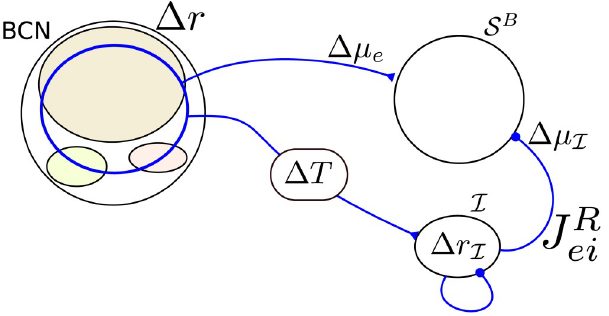
Fig 4. Tuning of the differentiator readout network to implement the operation of the differentiator readout scheme. A perturbation in the firing rate of the BCN ( Δ r ) causes a perturbation in the mean input to the RS readout neurons, Δ μ e , and a perturbation in the firing rate of the inhibitory readout population I . This change in firing rate causes a shift in the input from I to S B ( D m ). The strength of the connection from I to S B ( J R I D m þ D m � 0 . This cancellation reaches S B with a time lag Δ T so that the readout network roughly implements the I e operation of the DR Eq